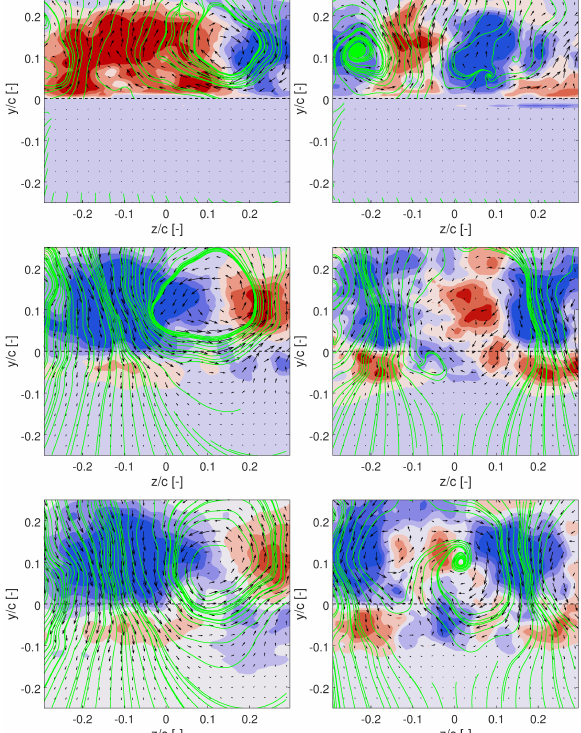
Fig. 14 . Parts of streamwise normal planes x/c = 1, 1.3, 1.5 (top to bottom). POD modes of velocity no. 7 (left) & 17 (right). Content ~2.5% & ~1.8% of